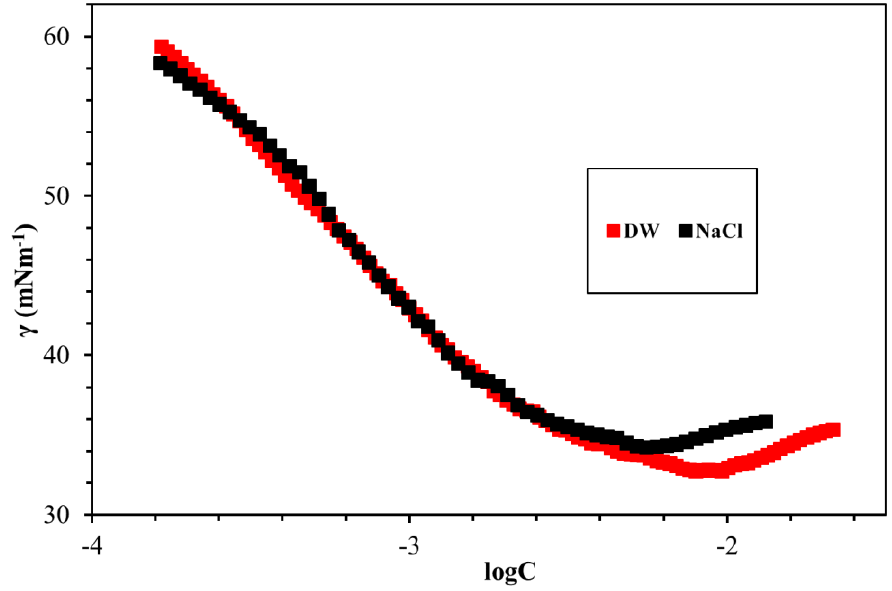
Figure 11. Comparison of surface tension of TEAH in DW and in 1M NaCl at 30 °C.